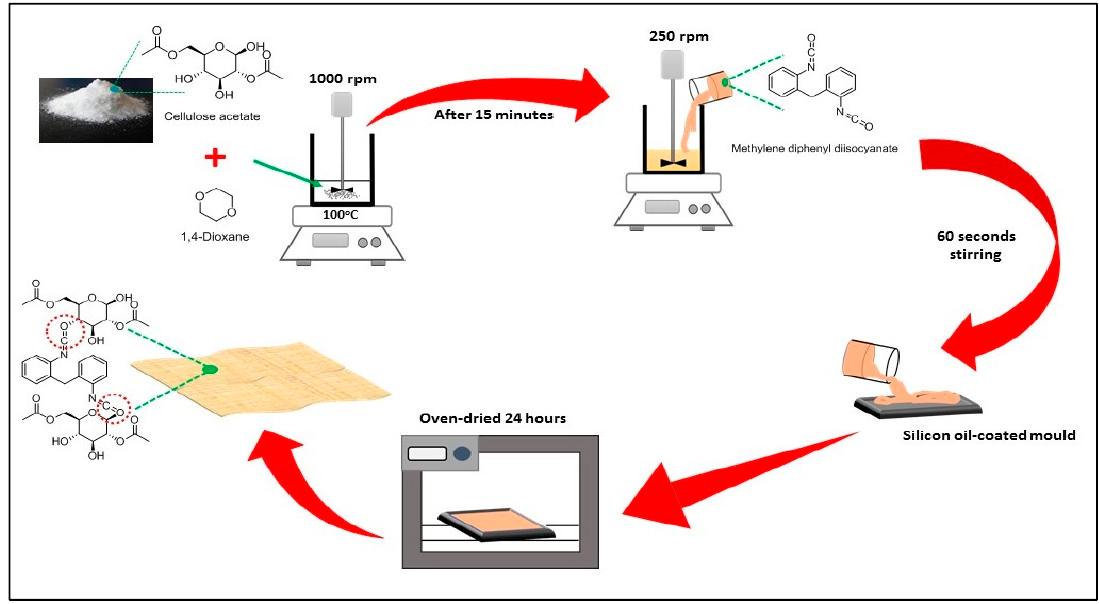
Figure 1. The preparation process of neat cellulose acetate (CA) and cellulose acetate–polyurethane (CA–PU) films.